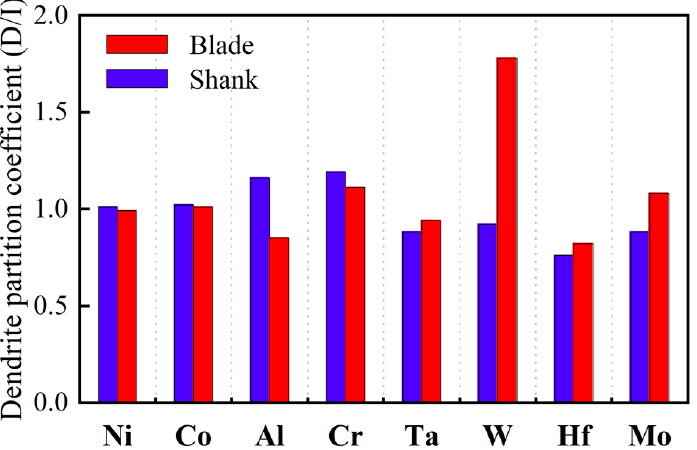
Figure 4. The segregation coefficient between dendritic stem and inter-dendrite of shank and blade. Through the comprehensive analysis of the blade in service, it is known that the ho- mogenization of the morphology can be promoted. However, the effect of the super-grav- ity on the microstructural degradation is still unknown as the distribution of the temper- ature in the blade is inhomogeneous. Therefore, the high-temperature centrifugal test was performed. Figure 5 shows the microstructures of the cast, aging, and super-gravity treat- ment specimens. The observation direction was the [001] direction. Figure 5a–c shows the cross-sections of the cast specimen. The cast microstructure in Figure 5a consists of the cross-shaped dendrite in light contrast and the surrounding inter-dendrite in dark con- trast. Figure 5b,c shows the enlarged microstructure in the dendrite and inter-dendrite regions. The γ and γ′ phases can be recognized, and the size of γ′ is much larger in the inter-dendrite. The magnitude of the difference in the size of γ′ phase is about ~5 times. Figure 5d–f shows the aging treatment specimen at 950 °C for 30 h without stress. The “black cross” contrast appeared in the dendritic stem of the dendrite structure after aging, as shown in Figure 5d. Figure 5e,f shows the microstructures of dendrites and inter-den- drite regions in high magnification. By comparison, the size of γ′ phase in the inter-den- drite is about 4~5 times higher than the size in the dendrite. Figure 5g–i shows the micro- structure in the bottom of the super-gravity treatment specimen at 950 °C for 30 h with 85 MPa stress. The dendrite morphology is still clearly visible in the dendrite section shown in Figure 5g. In Figure 5h,i, the size difference of γ′ phase decreases significantly, and the measurement statistics show that the size difference is about 2~3 times. This indicates that the homogenization effect is improved in the process of super-gravity treatment.